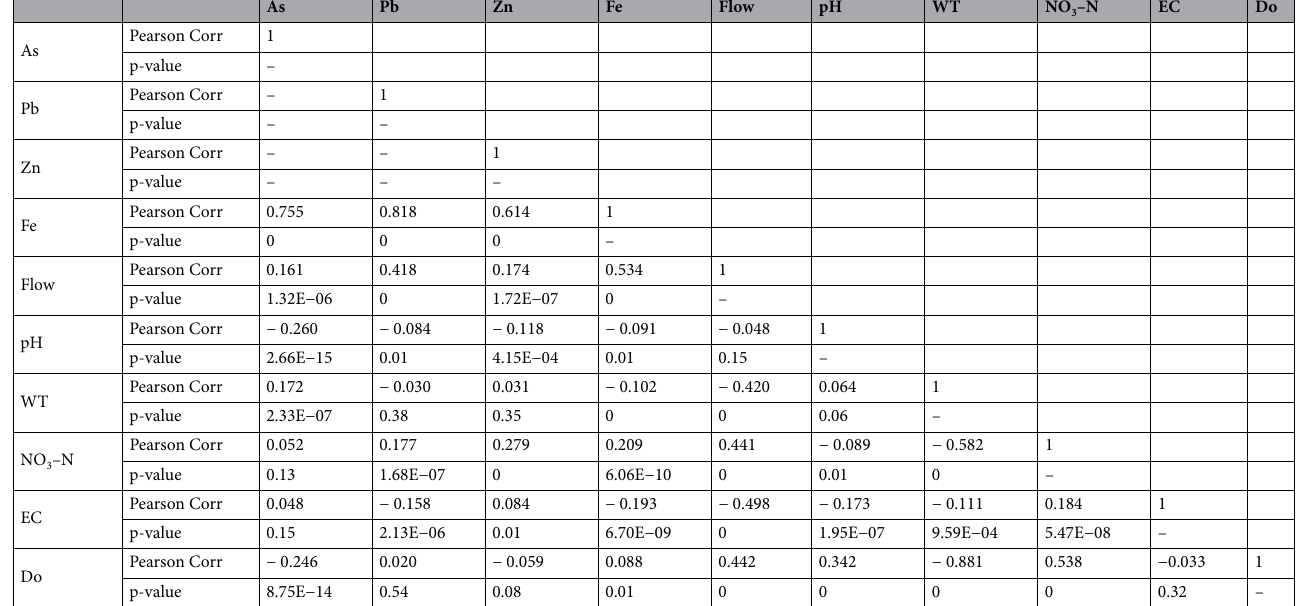
Table 2. Person correlation coefficients and significance analysis.